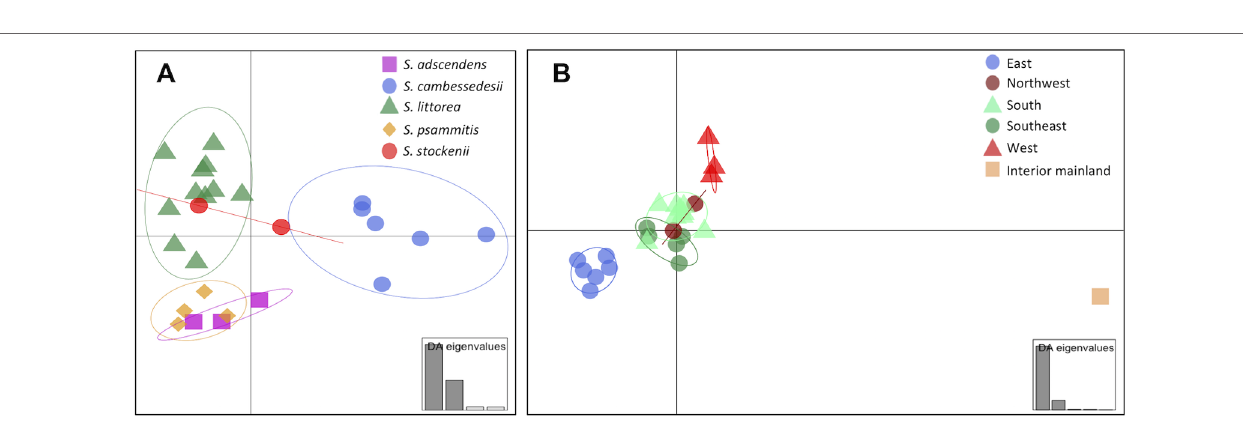
Frontiers in Plant Science |